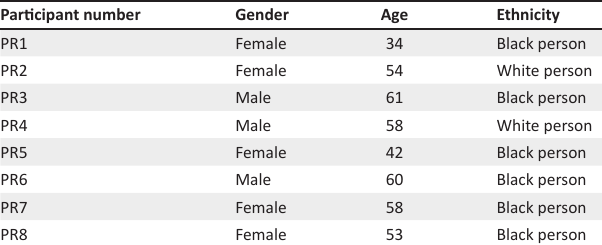
TABLE 1: Demographic profile of research